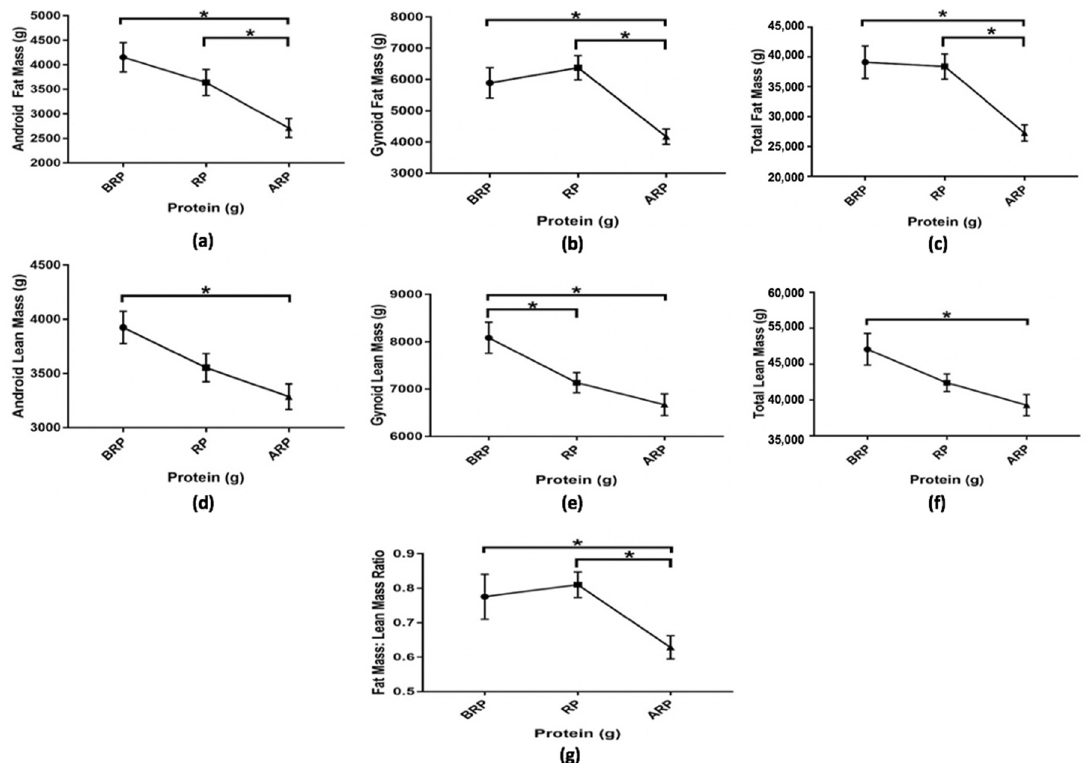
Figure 5. Among group di ff erences in android fat mass ( a ), gynoid fat mass ( b ), total fat mass ( c ), android lean mass ( d ), gynoid lean mass ( e ), total lean mass ( f ), and fat mass: lean mass ratio ( g ) of study participants below ( n = 17), meeting ( n = 22), and above ( n = 23) the recommended-protein groups (below recommended-protein group (BRP), recommended-protein group (RP), and above recommended-protein group (ARP), respectively). Values are reported as mean ± SEM. * Denotes significant di ff erences among groups ( p ≤ 0.05).